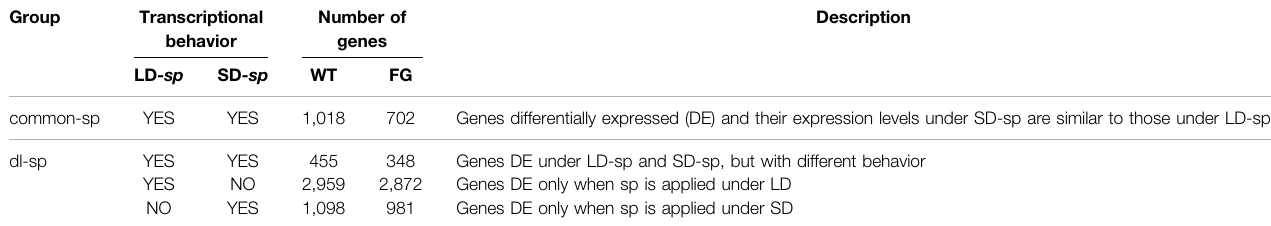
TABLE 1 | List of categories of differential expression genes affected by space fl ight under different photoperiods.